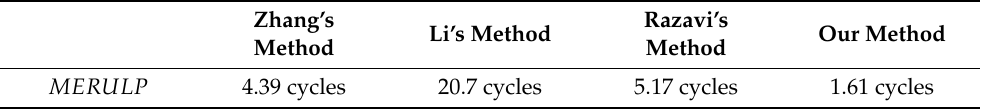
Table 3. The mean error of RUL prediction ( MERULP ) of different